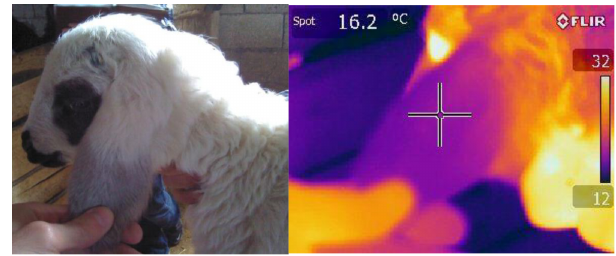
Figure 4. Infrared images of ear tissue after the application of elec- tronic ear tags in lambs (day